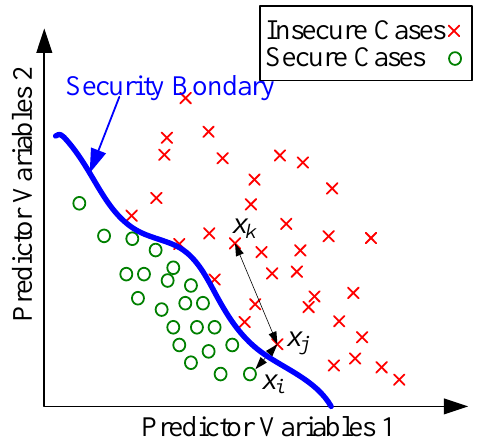
Figure 4. The illustration of the drawback of Euclidean Distance.